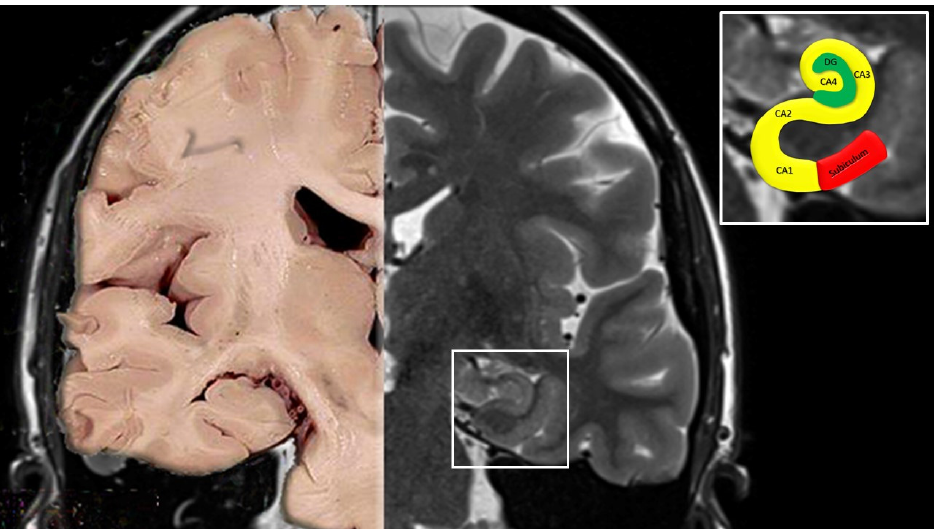
Figure 2. Coronal section of the brain from a normal autoptic case ( left ) and an MRI image ( right ). In the upper right box, the cornu ammonis with its 4 fields (CA1, CA2, CA3 and CA4) and the subiculum are highlighted.